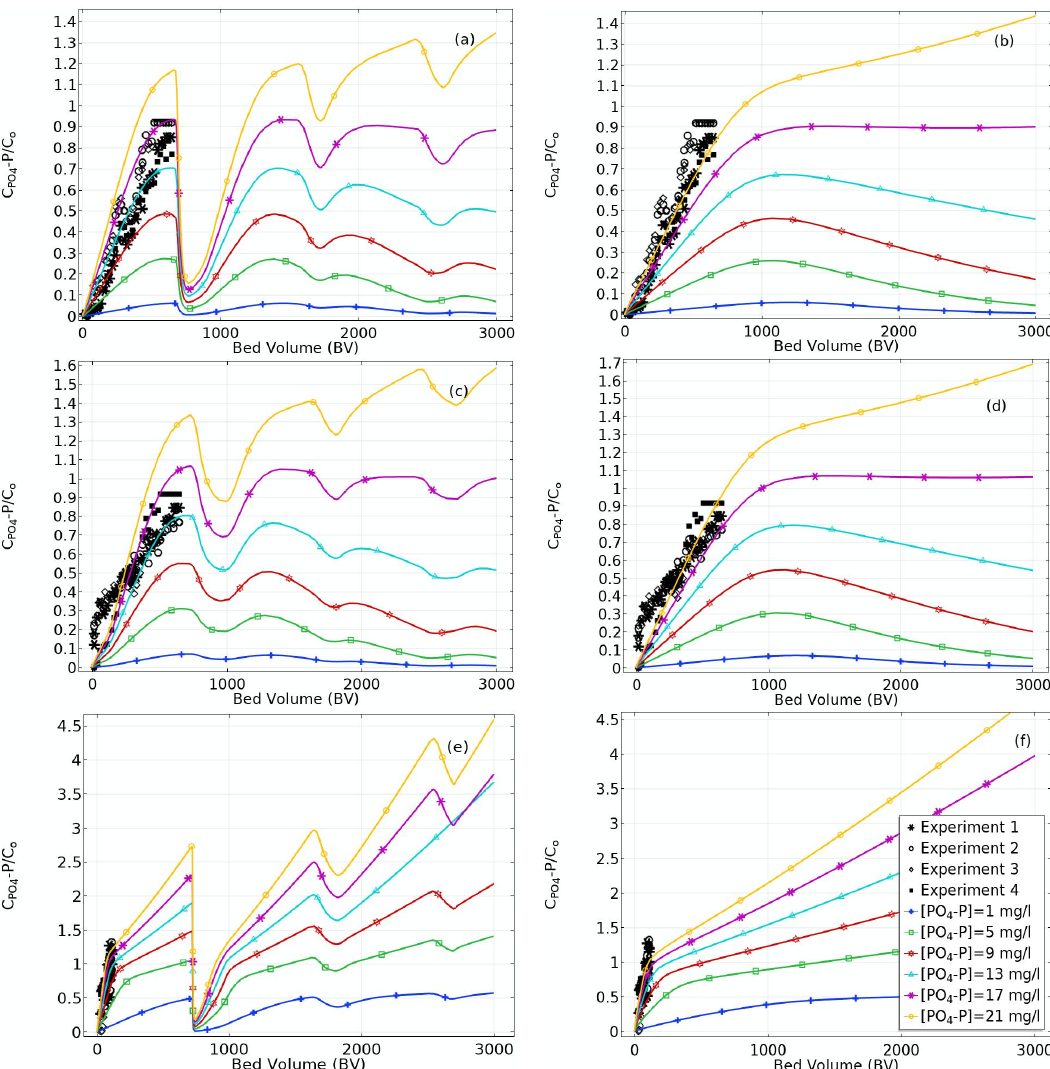
Figure 2. P breakthrough in the reactive filter materials (RFM) at a ratio of dissolved P concentration in effluent to influent (C/C 0 ) set at 1. Data from column experiments 1–4 [17] as black points and simulated data for a range of influent P concentrations shown as colored lines. (Legend in diagram (f)) Intermittent flow through (simulated breaks of 100 days after 750, 1750 and 2500 bed volumes (BV)): ( a ) Polonite, ( c ) Top16, ( e ) Filtralite P. Continuous flow through (right-hand diagrams): ( b ) Polonite, ( d ) Top16, ( f ) Filtralite P.